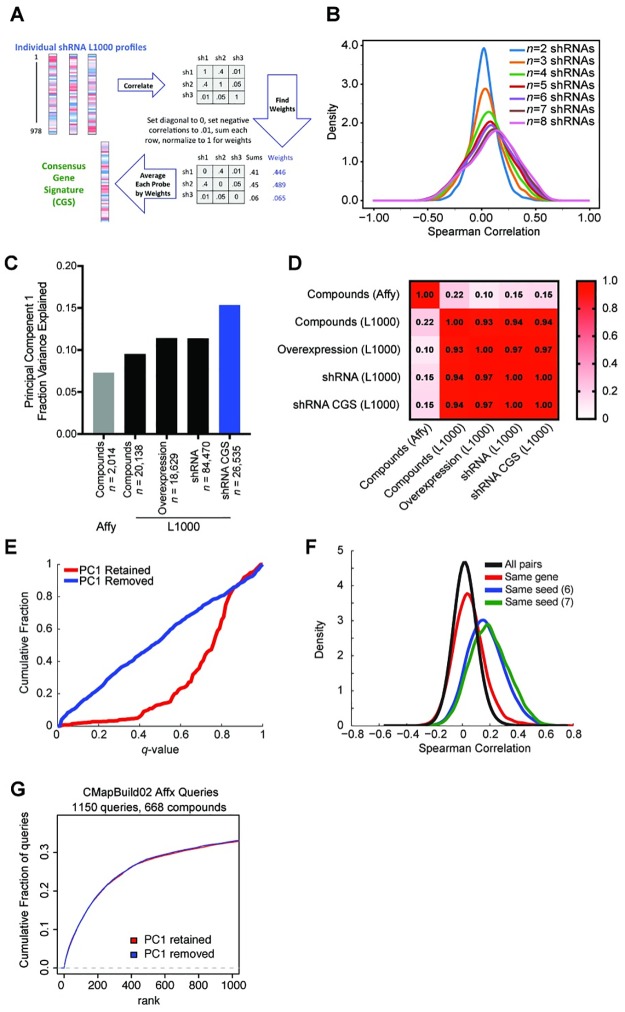
CGSs and investigation of PC1.(A) Schematic of the weighted average procedure for combining individual shRNA signatures targeting the same gene into a CGS. The shRNAs are weighted by the sum of their correlations to other same-gene shRNAs and then averaged. (B) CGSs made from random groups of shRNAs show increasing variance of Spearman correlation with larger numbers of component shRNAs. Because these are random groups, there should not be a consistent signal; the increasing probability of very large correlations reveals a spurious signal that we attribute to the PC1 of the data. (C) Comparison of the fraction of variance explained by PC1 for either CMAP build 02, which used Affymetrix arrays to profile small molecules [1], or the expansion of CMAP, which uses L1000 technology [5] with different types of perturbation. Level 5 data were used. The shRNA CGS has a notably larger PC1. See S3 Data. (D) Pearson correlation of PC1 across RNA measurement platforms and perturbation types in level 5 data. (E) For genes with 6 or more shRNAs, a fraction of statistically significant holdout results at different q-value-corrected false discovery rate thresholds, comparing PC1 retained or PC1 removed. Analysis was performed separately for each cell line and data for all cell lines are shown as a single distribution. Because holdout analysis combines multiple shRNA signatures, removal of PC1 decreases the background caused by the general increase in correlations shown in panel (B) and thus improves the performance of this particular analysis. (F) Removal of PC1 does not diminish the magnitude of the seed effect. After removal of PC1, distribution of pairwise Spearman correlations in HT29 (as a representative cell line) for pairs of shRNAs with the same gene target, the same 6- and 7-mer seed sequence, and all pairs of shRNAs. Compare to Fig 1C. (G) Effect of PC1 of CMAP queries. For small molecules previously profiled in CMAP build 02 by Affymetrix technology, the rank of the matched compound when queried against small molecule L1000 data, with either PC1 retained or removed. CGS, consensus gene signature; CMAP, Connectivity Map; PC1, first principal component; shRNA, short hairpin RNA.